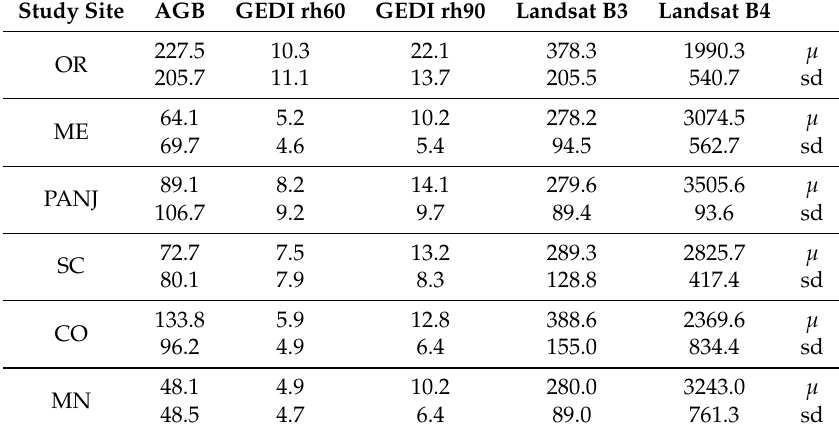
Table 3. Mean values and standard deviations of the study variables for each site.